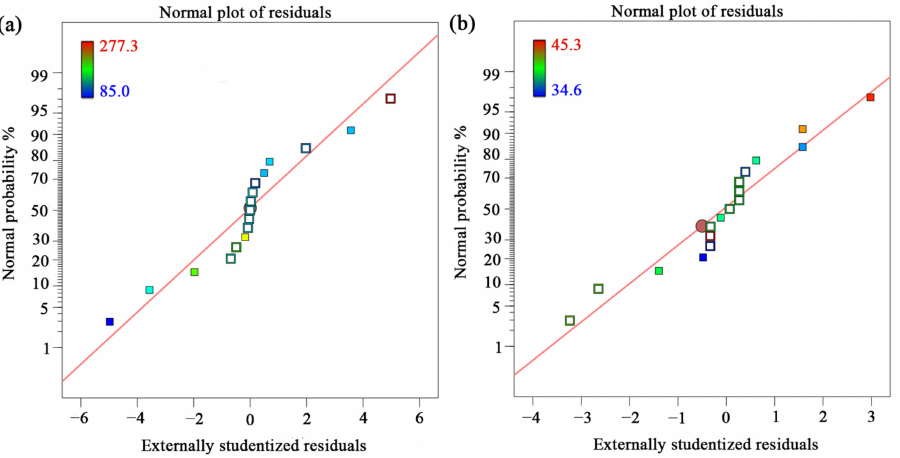
Figure 3. ( a ) Normal distributions of resultant force; ( b ) Normal distributions of cutting